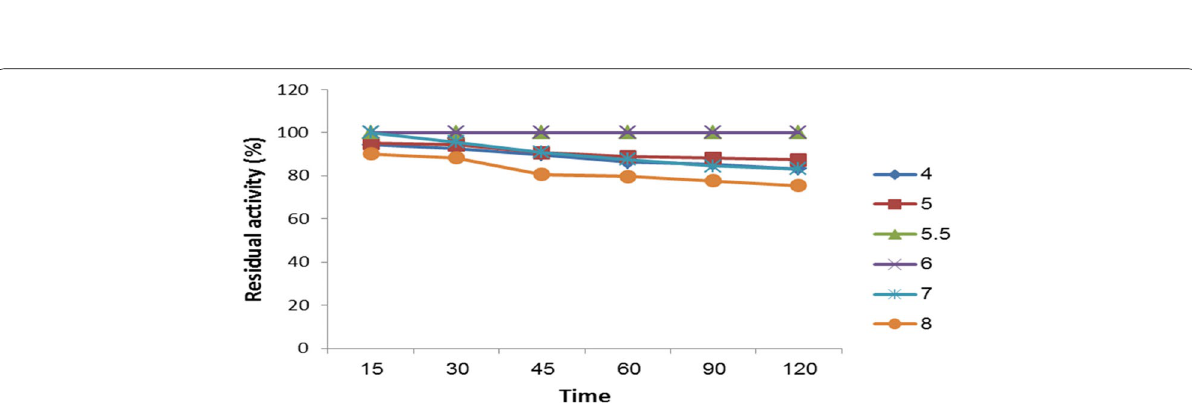
Fig. 7 pH stability of A. terreus strain RGS. Eg‑NRC xylanase. The enzyme solution was incubated at various pHs for various lengths of time, and the residual activity was evaluated under ideal